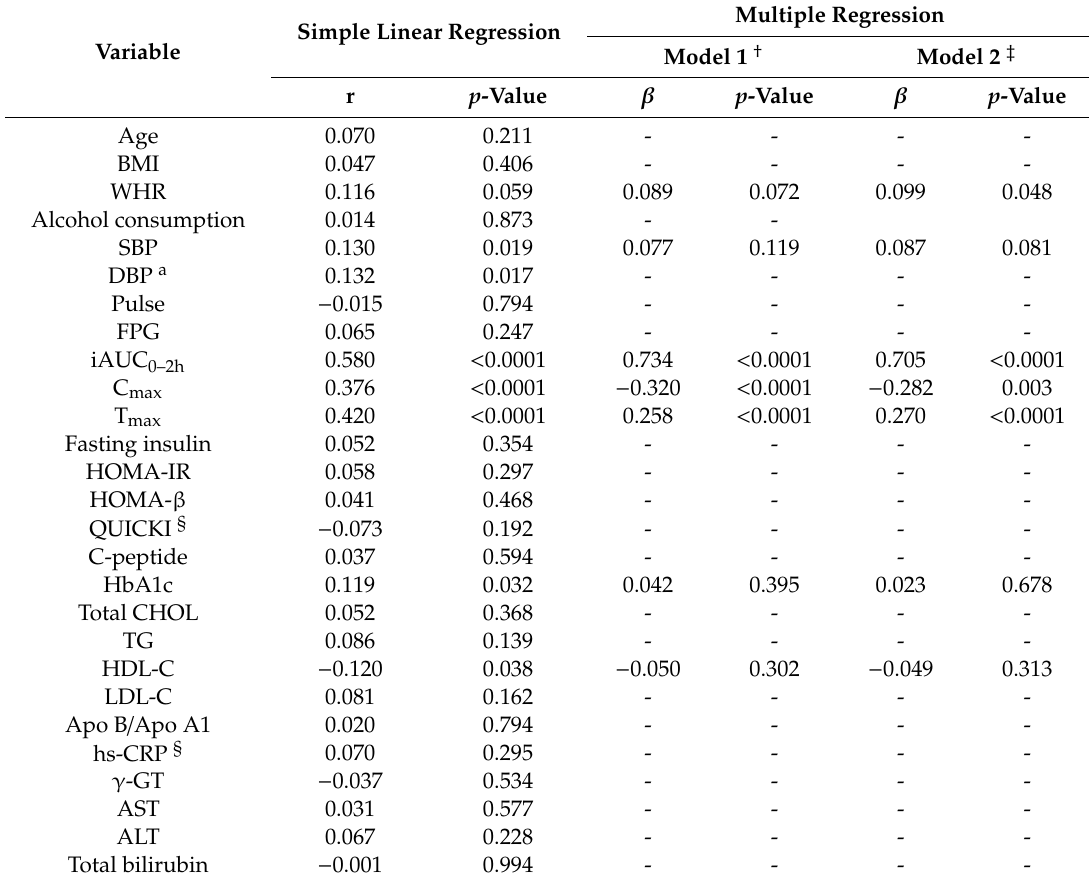
Table 5. Factors related to elevating 2h-PPG levels in subjects with